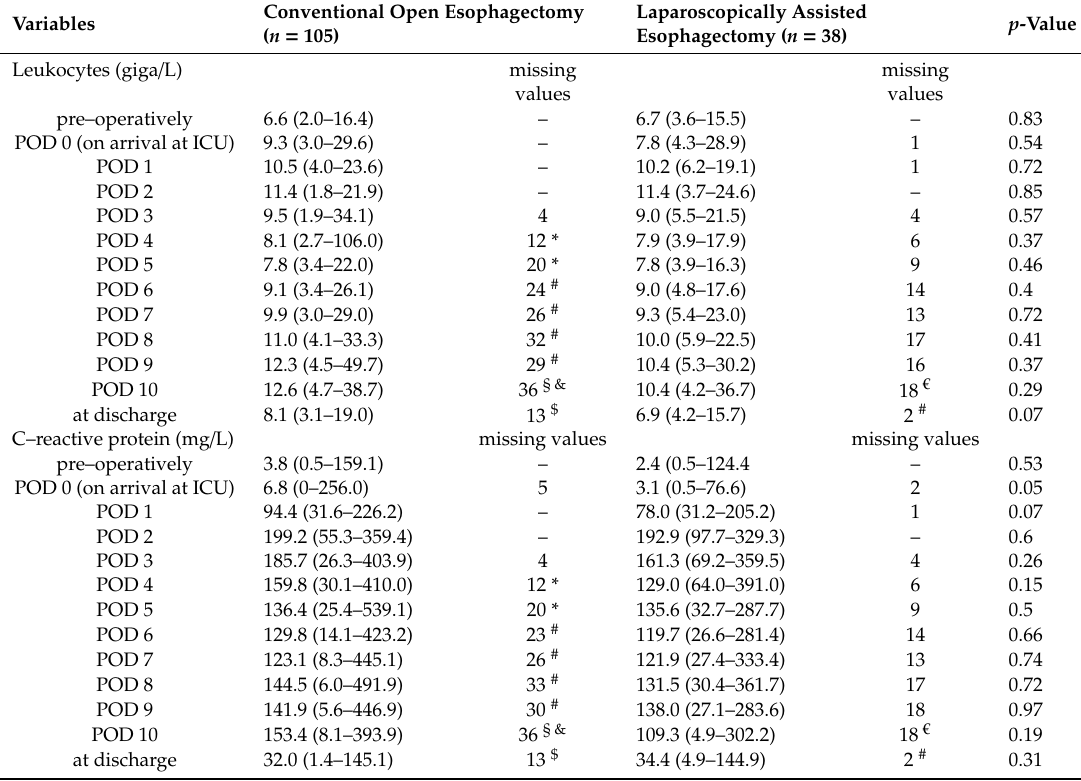
Table 3. Perioperative leukocyte counts and C-reactive protein